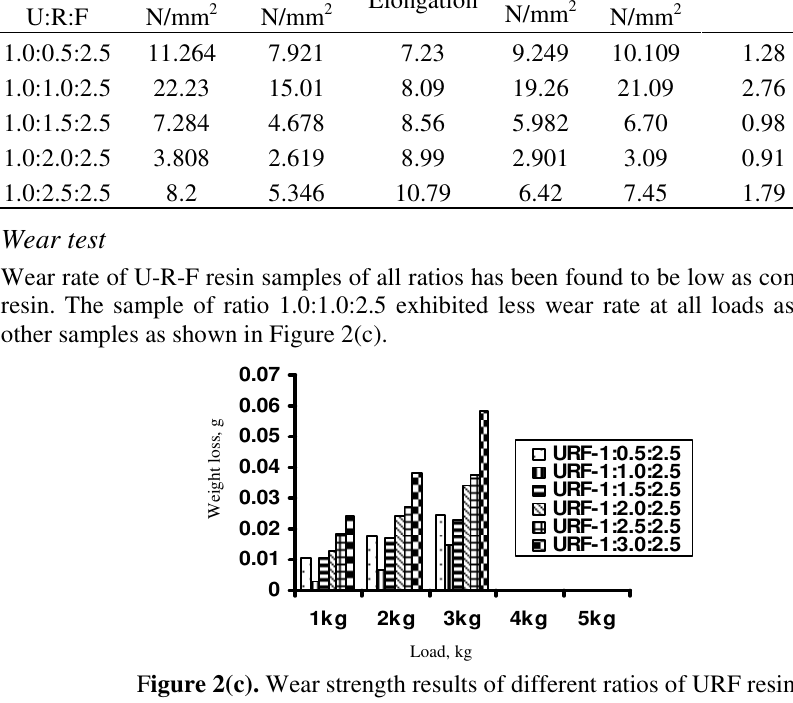
URF resin Sample